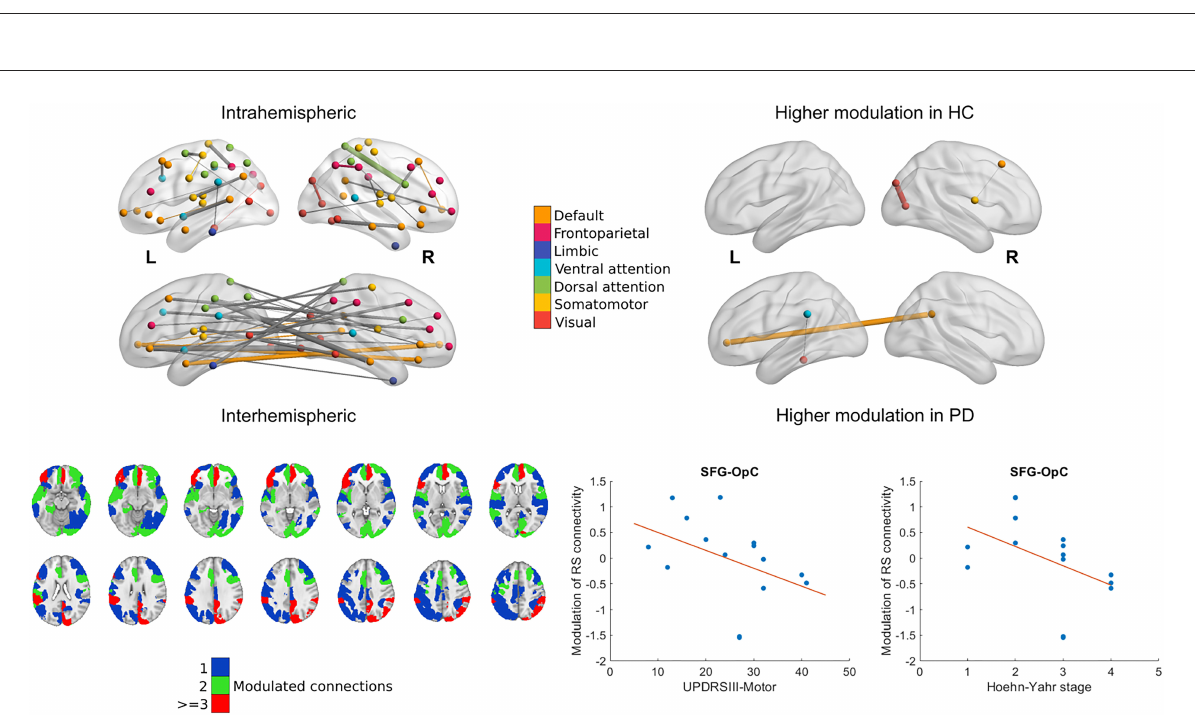
FIGURE3 Modulation of cortical resting-state functional connectivity during the task. The 3D representations show relevant intra- and interhemispheric connections that were consistently modulated during the task in the healthy group (marked by a change with an effect size of at least t = 3.1 in connectivity; left) or were modulated differently in the healthy and PD cohort (right). Nodes and within-network edges are color-coded according to their overlap with the 7-network parcellation in (27); between-network edges are shown in gray. Axial slices show parcels from the Schaefer atlas with at least 1 connection modulated consistently group-wise during the task. Parcel ROIs were overlaid on the MNI152 1mm brain template and are shown in neurological orientation. Scatter plots show the statistically significant association between clinical characteristics and modulation of the superior frontal gyrus (SFG)–opercular cortex (OpC) connection in the PD cohort with a least-squares line